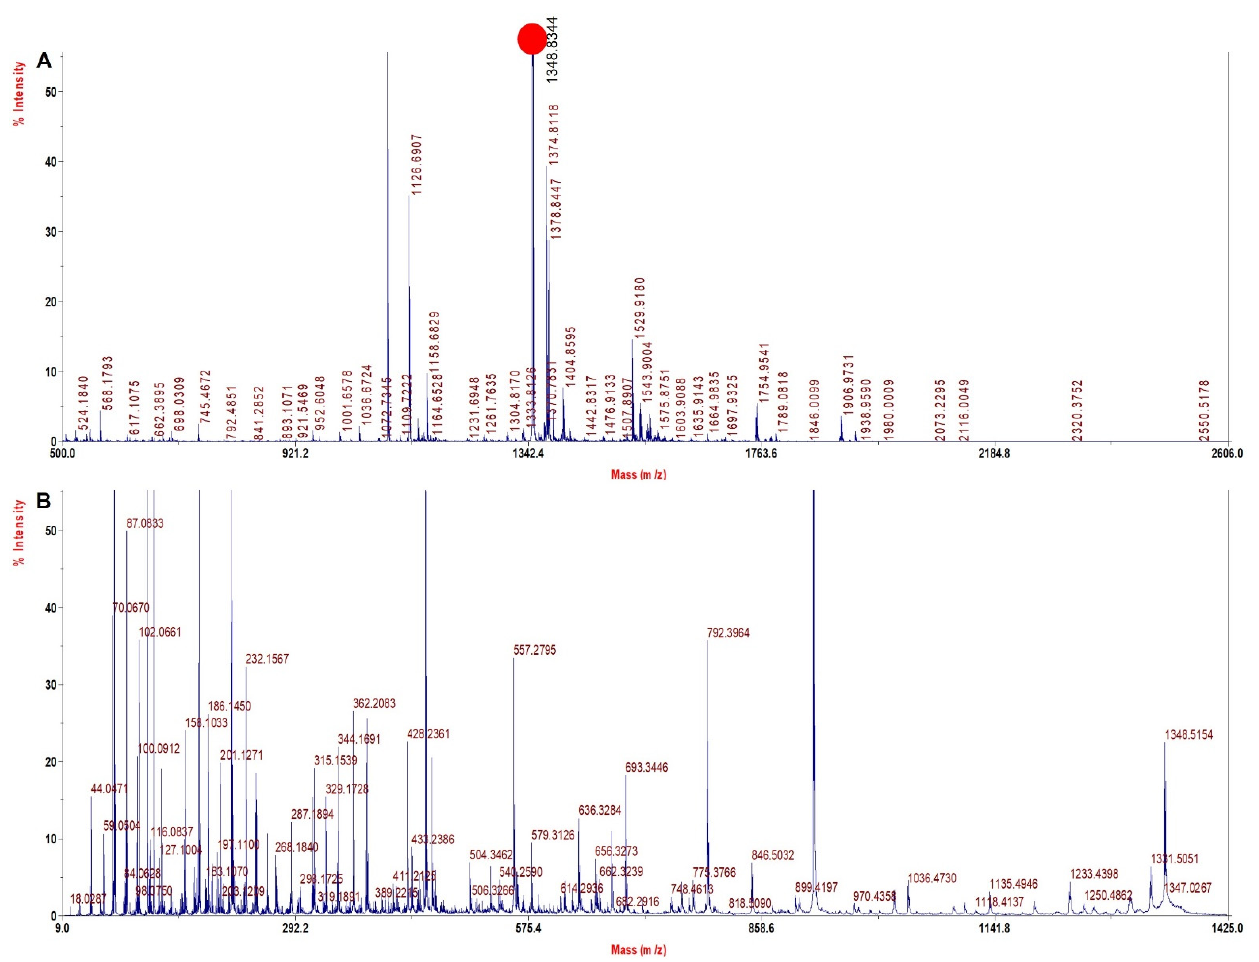
Figure 3. MALDI − MS and MALDI MS/MS spectra for the signature peptide from Mutant 2: Beta 28 (B10) Leu > Phe ( A ). PMF spectrum showing signature peptide obtained by TFE treated in − solution tryptic digestion. ( B ) MALDI − MS/MS spectrum of the signature peptide 1348.4 m/z of mutant 2.